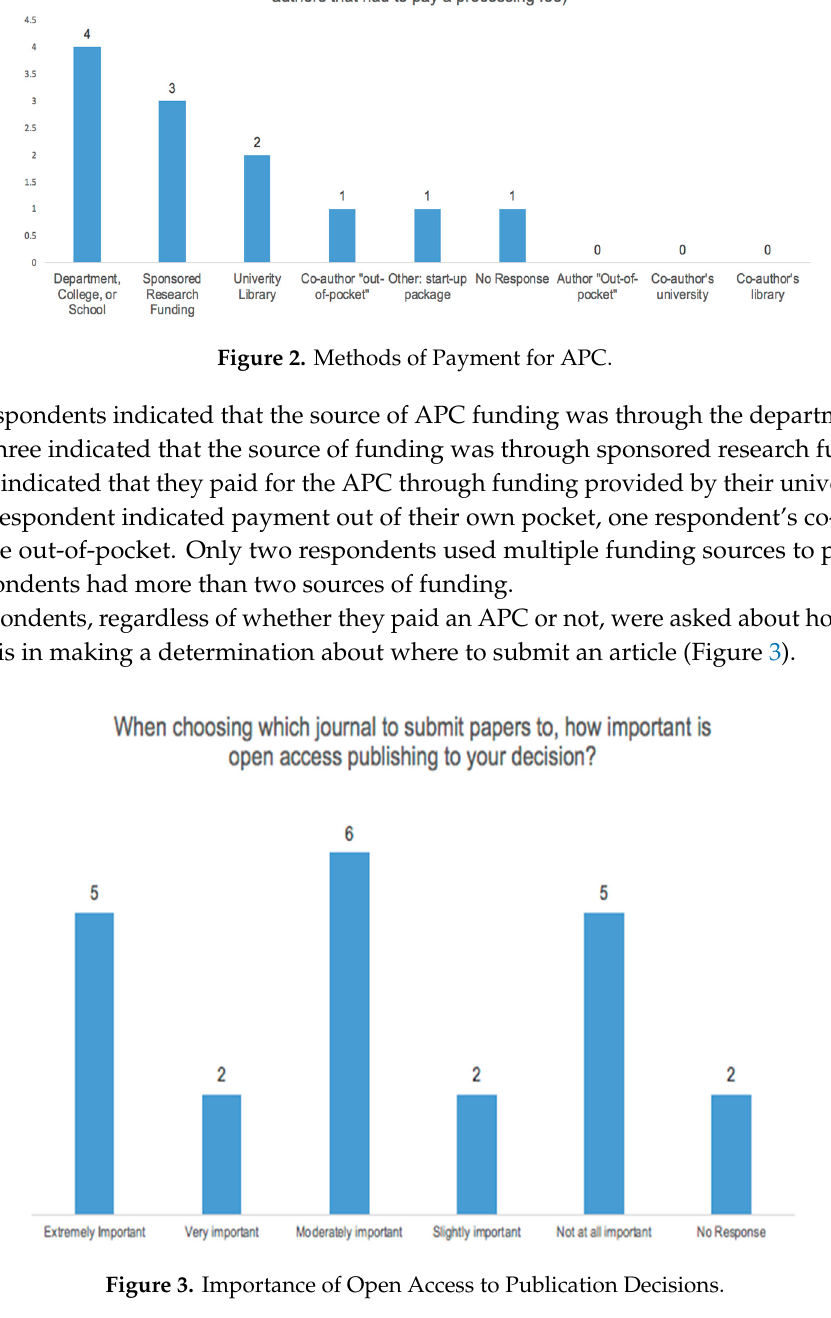
Figure 3. Importance of Open Access to Publication Decisions.